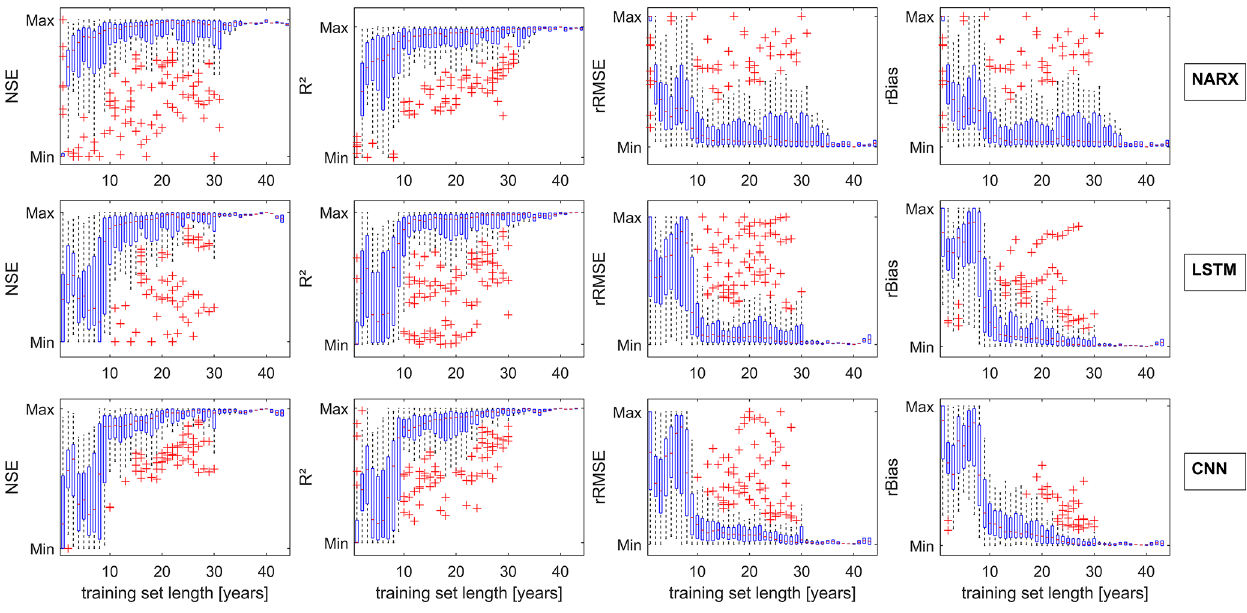
Figure 10. Influence of training data length on model